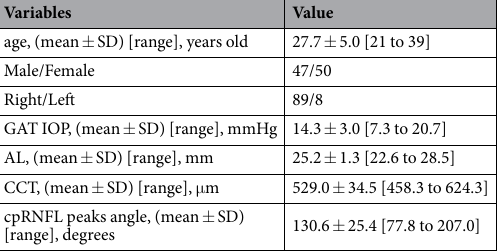
Table 2. Subject demographics and summary ocular measurements. GAT: Goldmann applanation tonometry, IOP: intraocular pressure, AL: axial length, CCT: central corneal thickness, cpRNFL: circumpapillary retinal